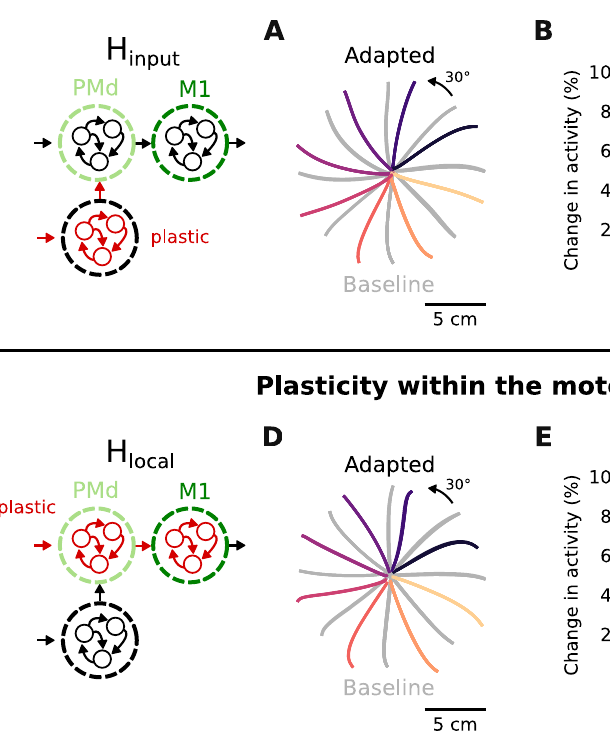
Fig.4|Activitychangesfollowinglearningupstream(H input )andwithin(H local ) the motor cortices. A Hand trajectories after learning under H input (coloured tra- ces; baseline trajectories are shown in grey). B Changes in trial-averaged activity following adaptation under H input (green markers) for PMd and M1, and reference mean experimental values (black stars; same data as presented in Fig. 2). Shaded area and horizontal bars, data distribution with meanand extrema ( n =10 network